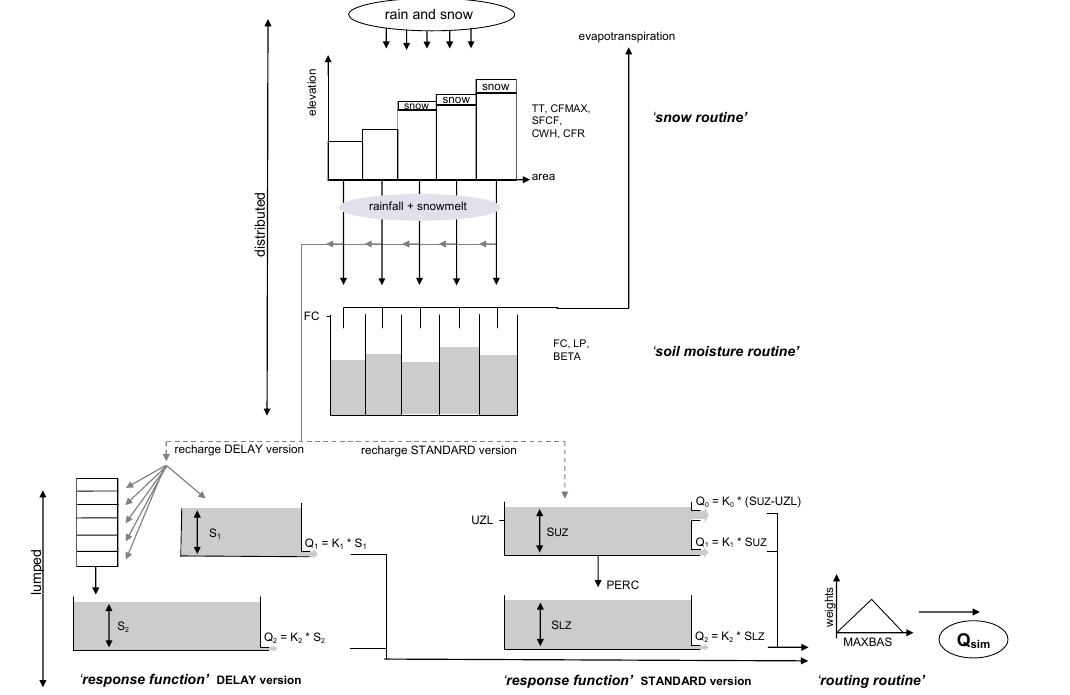
Fig. 3. Structure of the HBV model with two versions for the response routine: on the right-hand side the STANDARD version, and on the left-hand side the DELAY version (adapted from Seibert, 2000 and Oosterwijket al., 2009).